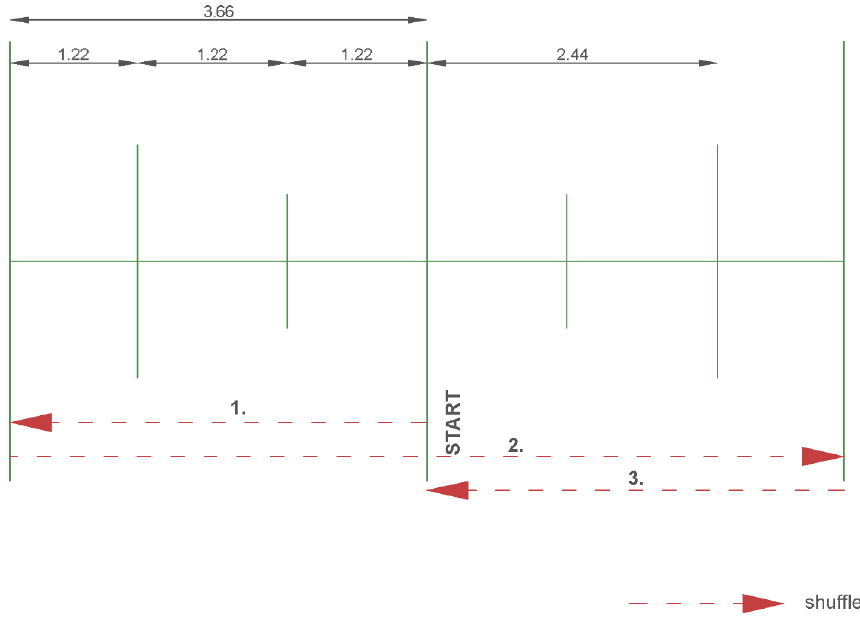
Figure 5. Edgren Side-Step Test 4 lateral shuffle tests (LST); adapted and edited from [32].